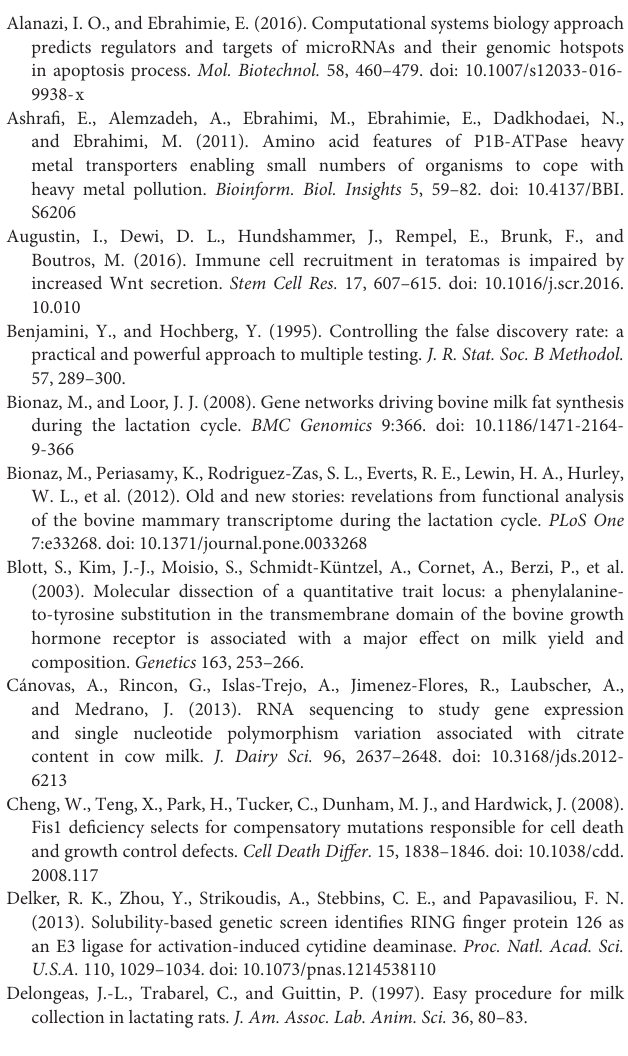
DATA SHEET S4 | The networks for DEGs were constructed using the neighbor joining algorithm. DATA SHEET S5 | The networks for DEGs were constructed using the common target algorithm. DATA SHEET S6 | The networks for DEGs were constructed using the common regulation algorithm. DATA SHEET S7 | Statistically significant subnetworks with downstream neighbors by down-regulated. DATA SHEET S8 | Statistically significant subnetworks with downstream neighbors by up-regulated. DATA SHEET S9 | Statistically significant subnetworks with upstream neighbors by down-regulated. DATA SHEET S10 | Statistically significant subnetworks with upstream neighbors by up-regulated. DATA SHEET S11 | The number of attribute weighting algorithm for all common